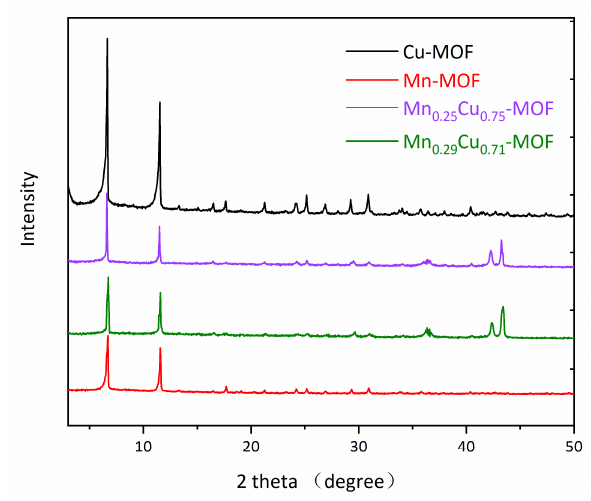
Figure 2. Powder X-ray diffraction patterns of Cu-MOF, Mn-MOF, Mn 0.25 Cu 0.75 -MOF, and Mn 0.29 Cu 0.71 -MOF.